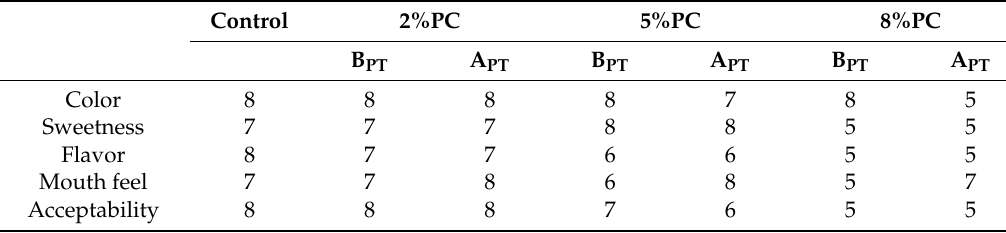
Table 3. Results of sensory evaluation of control and protein enriched mango puree before and after pressure treatment (higher values represent better acceptability) (B PT -before pressure treatment; A PT -after pressure